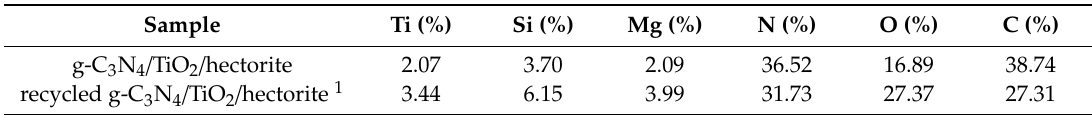
Table 1. The relative atomic content of surface elements for g-C 3 N 4 / TiO 2 / hectorite reused before and after measured by y X-ray photoelectron spectroscopy (XPS).